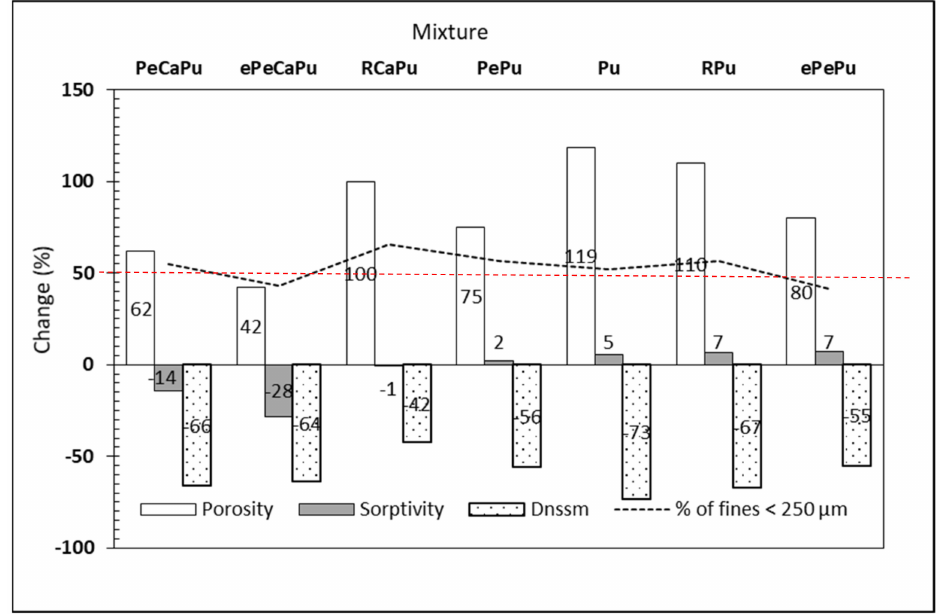
Figure 3. Changes (%) in OP, S, and D nssm of LWC mixtures at the age of 28 days compared to reference mixture (REF) and with respect to the content (%) of fines <250 µ